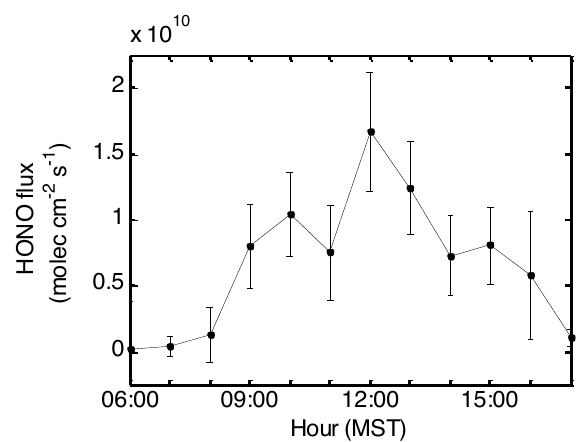
Figure 7. Sunny days hourly average vertical HONO fluxes derived from the HONO gradient observations during UBWOS 2012. Error bars show the 1 σ uncertainty of the respective data points